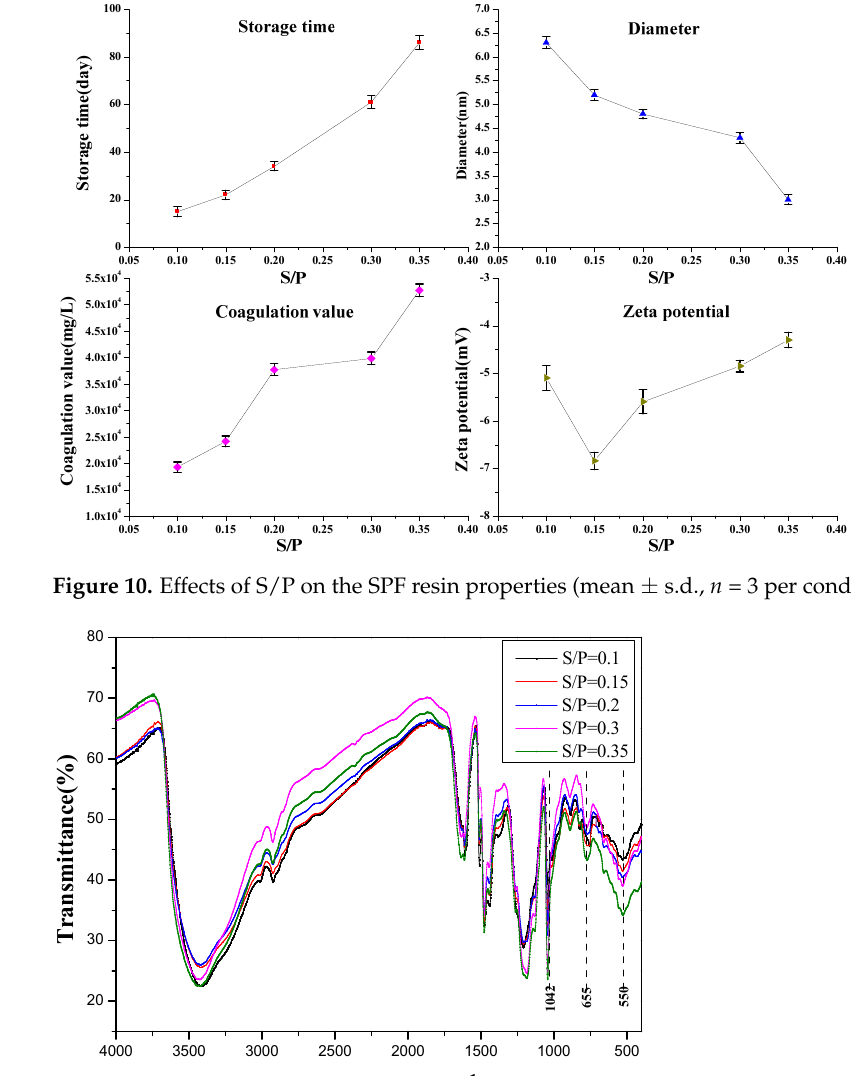
Figure 11. FTIR spectra of SPF resins with different S/P in the range of 0.1–0.35.